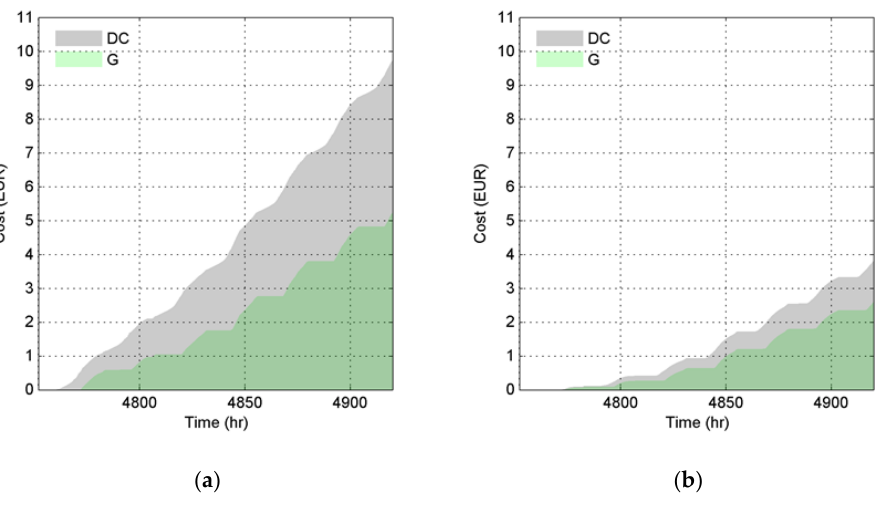
Figure 15. Cost composition, comparison between RBC ( a ) and MPC (OF C , PH of 18 h) ( b